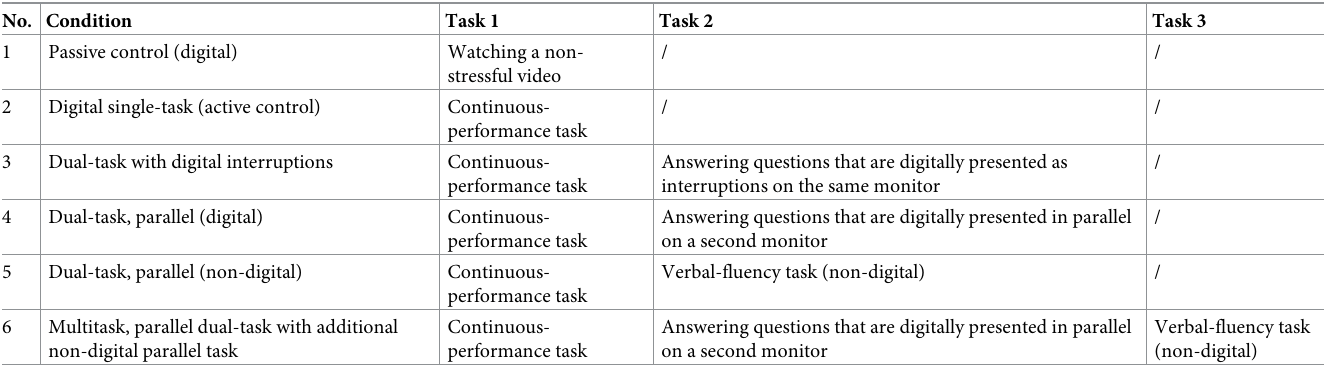
Table 1. Tasks that will be used in the six experimental